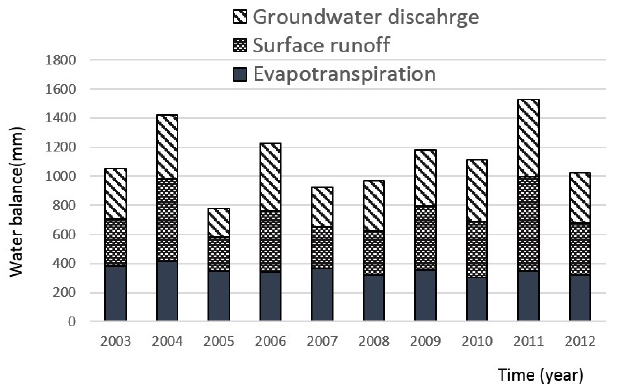
Figure 3. Annual variation of the water